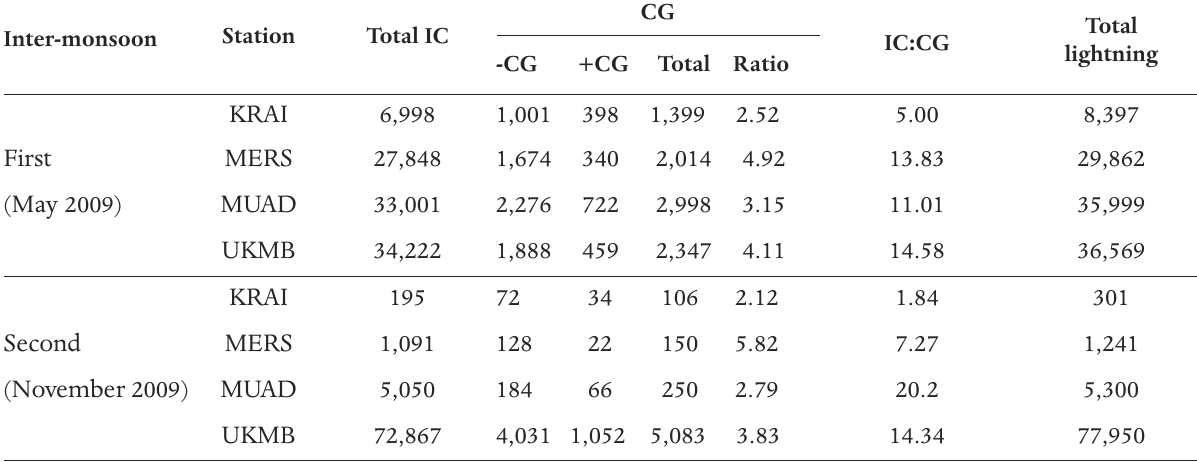
Table 3. Lightning activities during the 2009